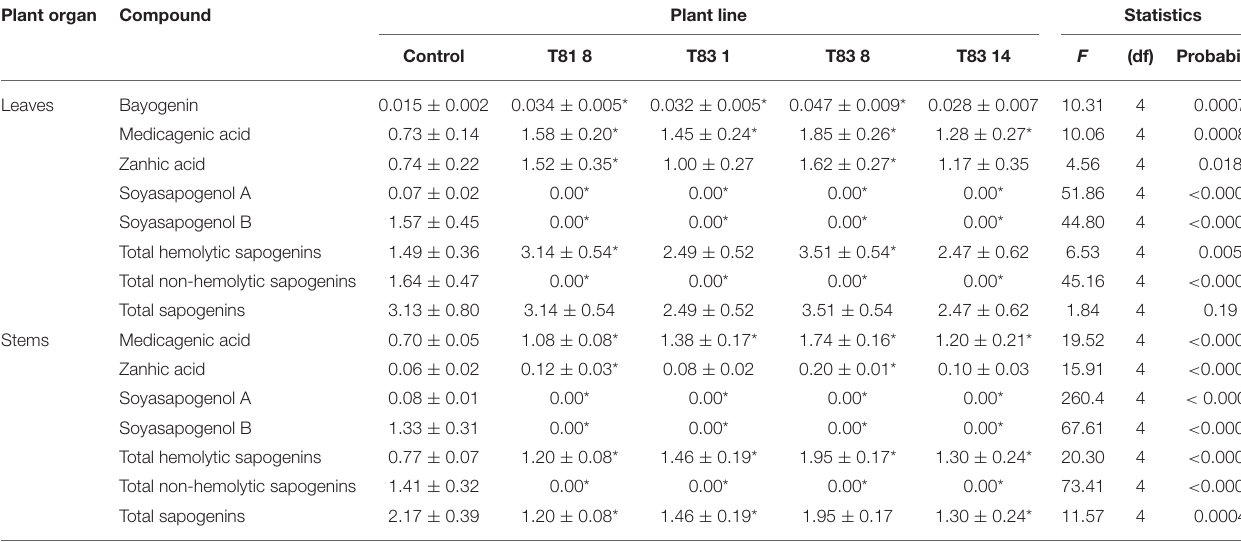
TABLE 1 | Sapogenin content in aerial parts (leaves and stems) of control and CYP93E2 mutant barrel medic plant lines under greenhouse experimental conditions. Plant organ Compound